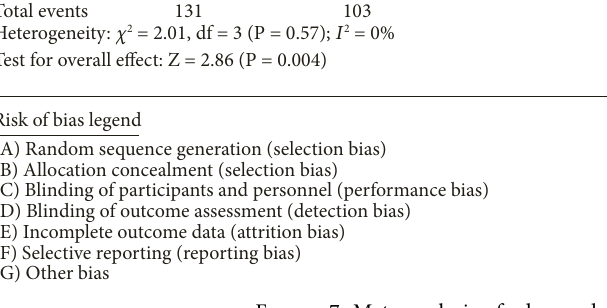
Figure 7: Meta-analysis of adverse drug reaction between two